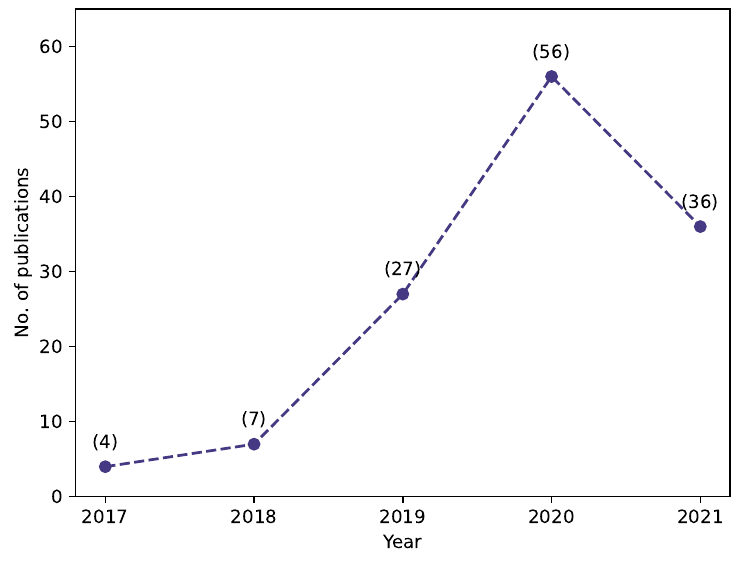
Figure 2. Number of publications per year included in the